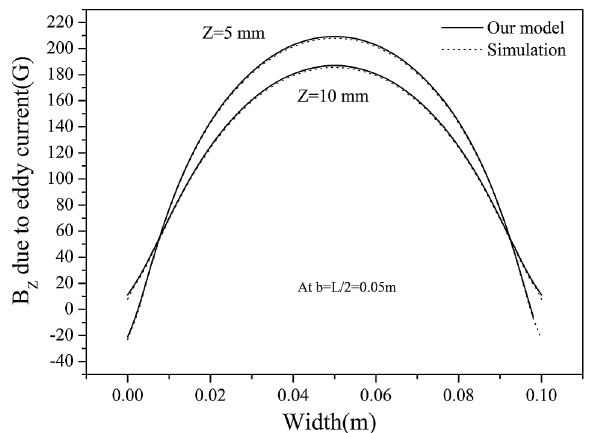
FIG. 8. Vertical component of the magnetic field due to eddy current flow in the SS plate at 50 Hz frequency and 1.2180 T peak field for two distances z ¼ 5 and 10 mm from the plate, respectively. Simulation results (dotted lines) are also plotted for comparison.